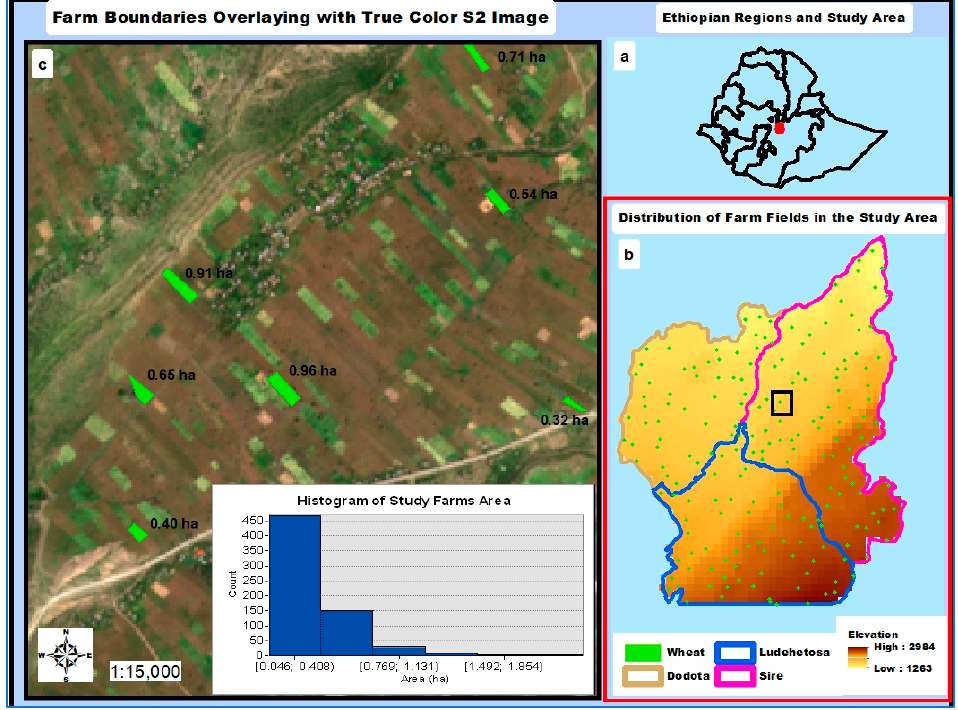
Figure 1. Location of the study area ( a ), study districts ( b ) and farm distribution (points) ( b ) as well as some farm boundaries (polygons), ( c ) and histogram of study farm areas.